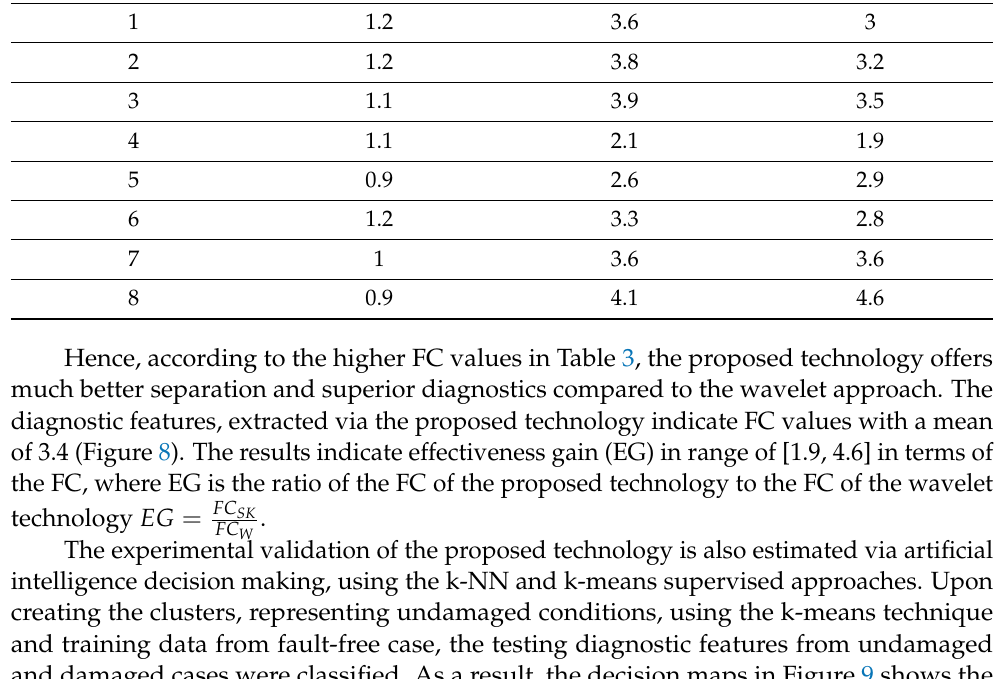
Figure 8. The FC measures of diagnostic feature separation between inner race defect and undamaged case. Table 3. Comparison of FC for the wavelet approach [5] and the proposed approach. Rolling Element